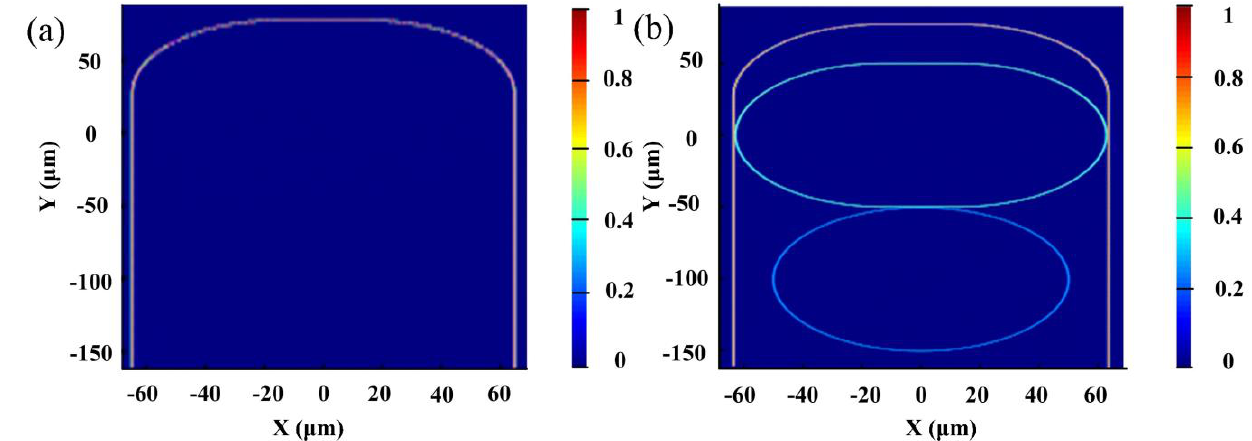
Figure 3. Calculated electric field distribution of the gourd-shaped resonator for ( a ) nearly no resonance coupling at a wavelength of 1550 nm, and ( b ) critical optical coupling at a wavelength of 1548.56 nm.